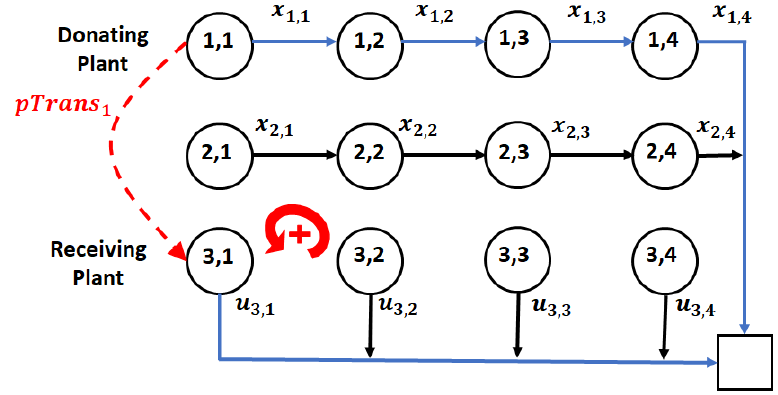
Figure 7. Cycle formed by addition of the arc pTrans 1